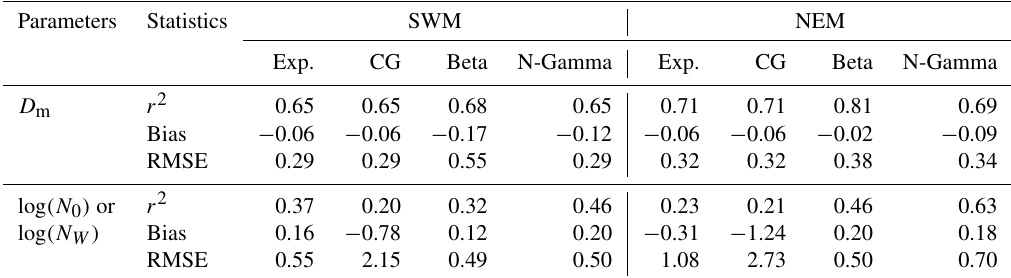
Table 6. Evaluation statistics of D m and log N 0 /N W by the Exp., CG and N-Gamma β methods for SWM and NEM. Parameters Statistics SWM NEM Exp. CG Beta N-Gamma Exp. CG Beta N-Gamma D m r 2 0.65 0.65 0.68 0.65 Bias − 0.06 −